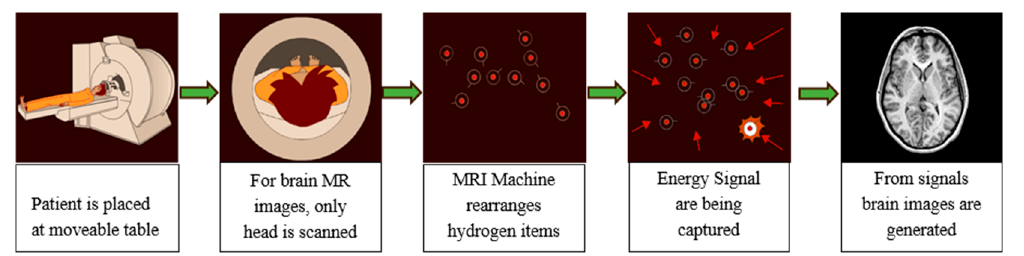
Figure 2. MR image capturing process from MRI